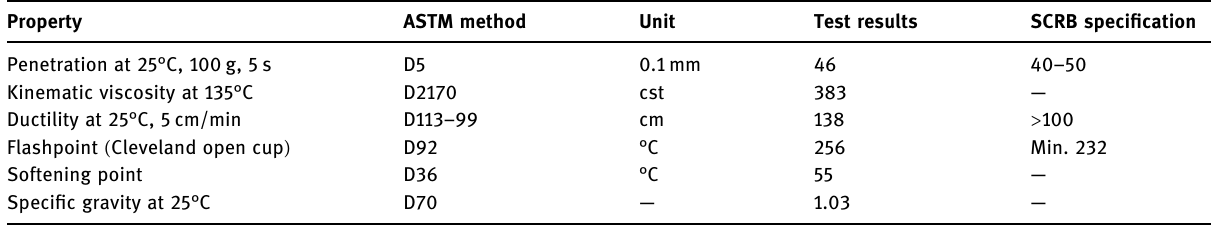
Table 1: ( 40 – 50 ) Asphalt binder